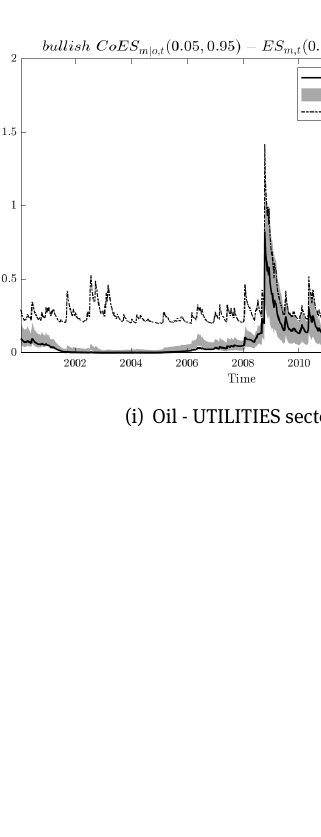
Figure 21c: CoES m | o , t (0.05, 0.95) for a certain sector given a bearish scenario for oil